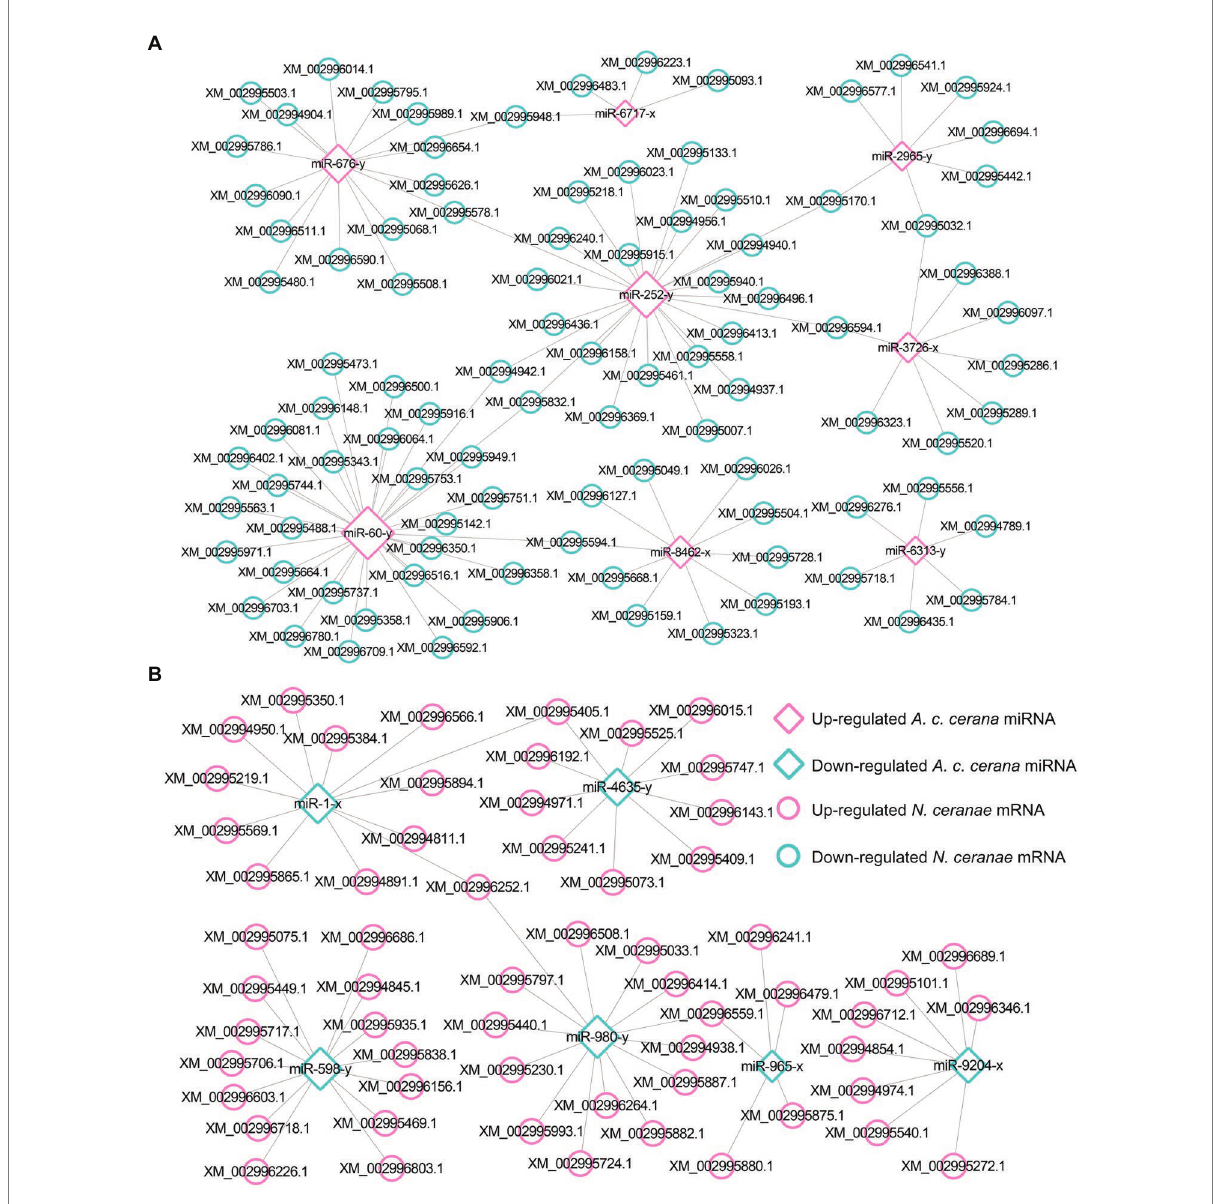
FIGURE 1 Regulatory network between A. c. cerana DEmiRNAs and target DEmRNAs in N. ceranae at 7 dpi. (A) Regulatory network between up-regulated miRNAs in host and down-regulated mRNAs in microsporidian. (B) Regulatory network between down-regulated miRNAs in host and up- regulated mRNAs in